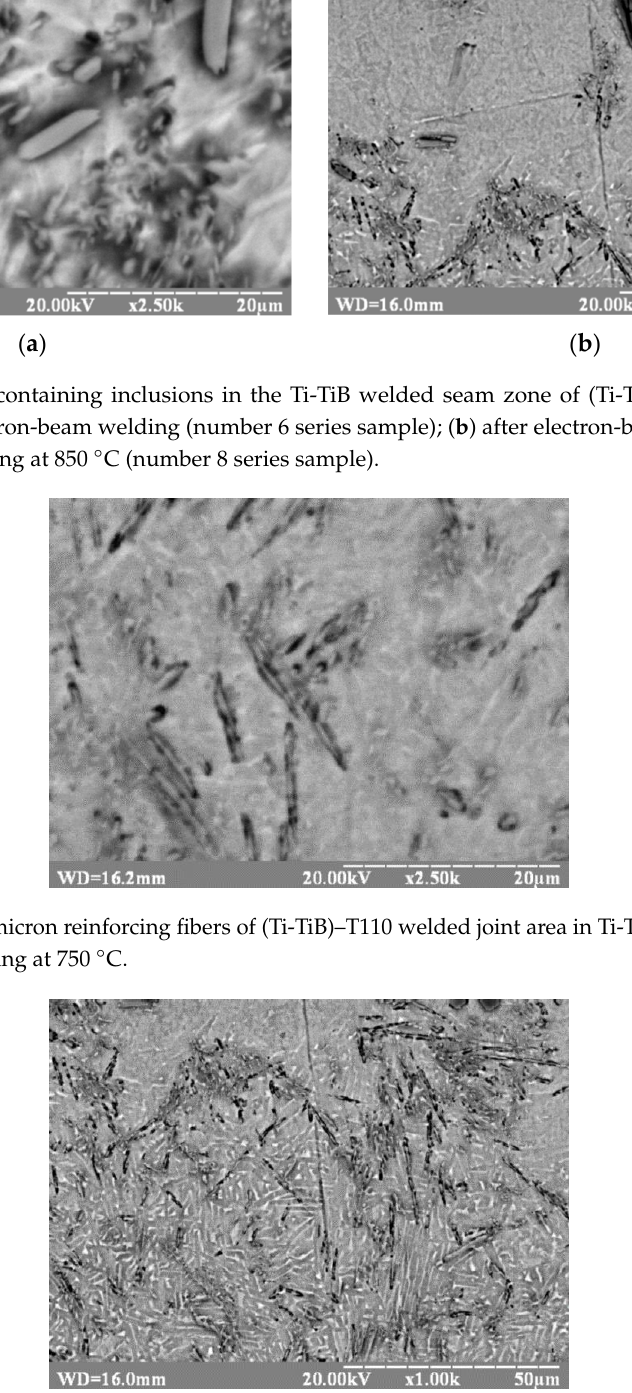
Figure 15. Network of TiB-reinforcing fiber clusters in Ti-TiB—welded seam zone (T110)—after annealing at 850 °С.